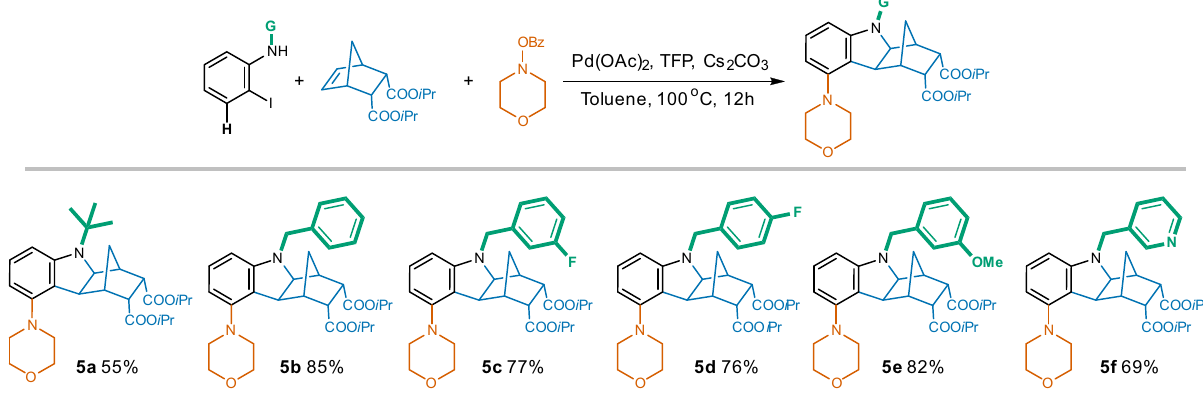
Fig. 7 In fl uence of N -substituents on the production of 5-substituted hexahydro-1 H -1,4-methanocarbazoles. Reaction conditions: N -substituted 2-iodoaniline (1.0 eq.), NBE-5,6-diCOO i Pr (1.0 eq.), morpholino benzoate (1.3 eq.), Pd(OAc) 2 (5% eq.), TFP (10% eq.), Cs 2 CO 3 (2.5 eq.), toluene, 100 o C, 12